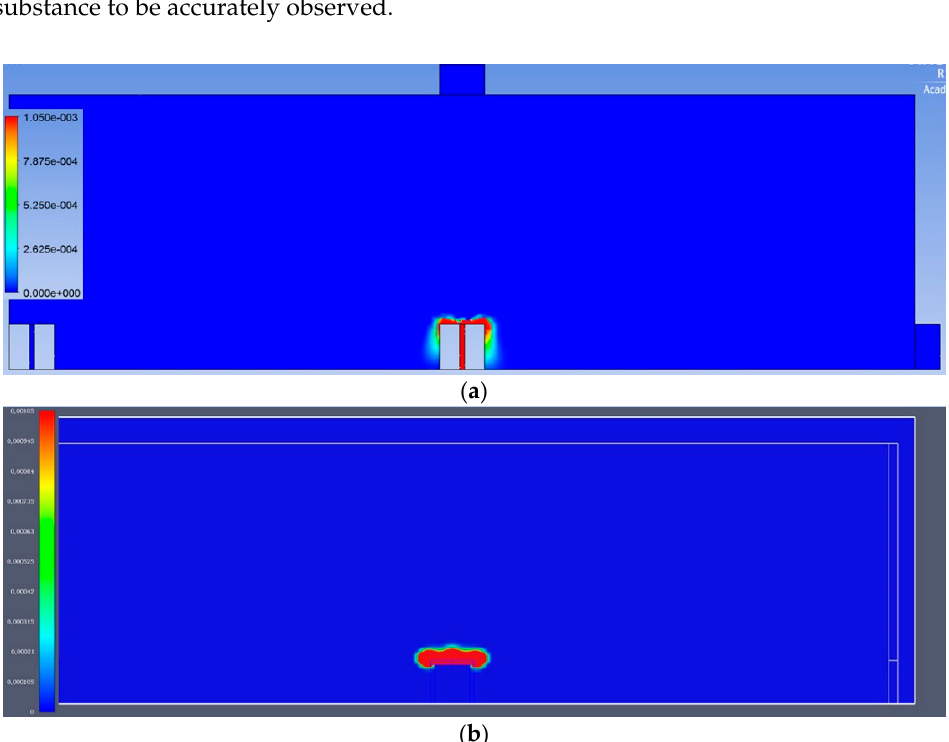
Figure 6. Iso-surface for propane representing 50% concentration of LEL for ( a ) Ansys software and ( b ) FDS.